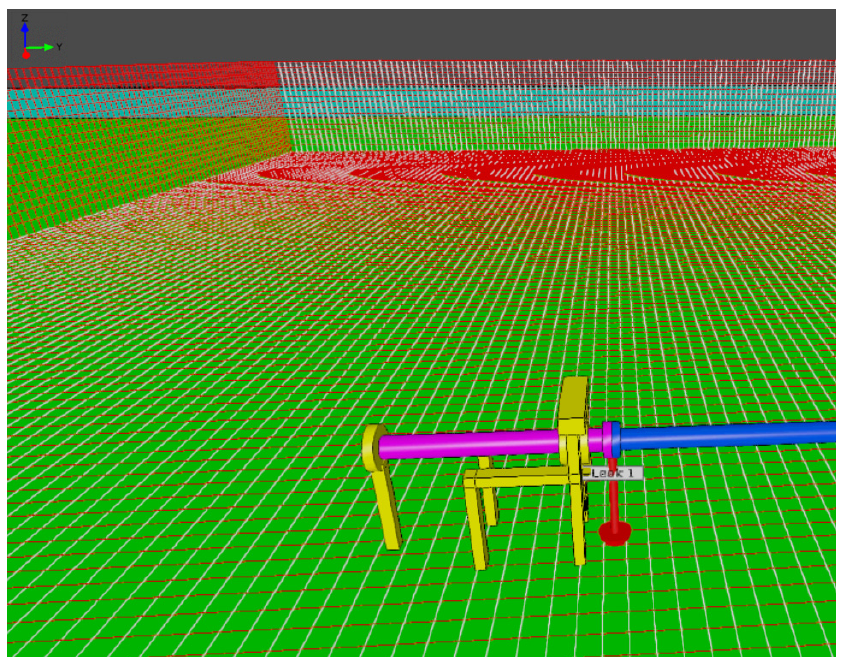
Figure 3. Grid use for the simulation.